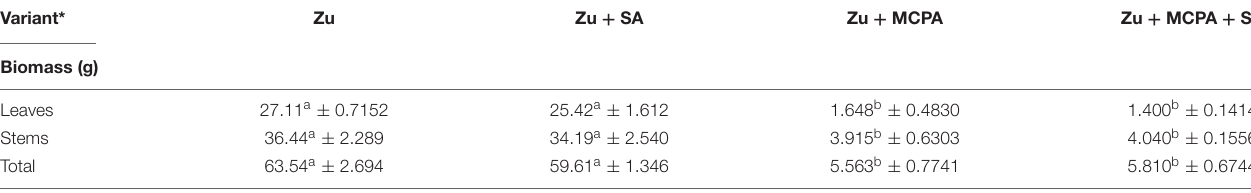
TABLE 2 | Fresh weights of leaves and stems and total aboveground biomass of zucchini.